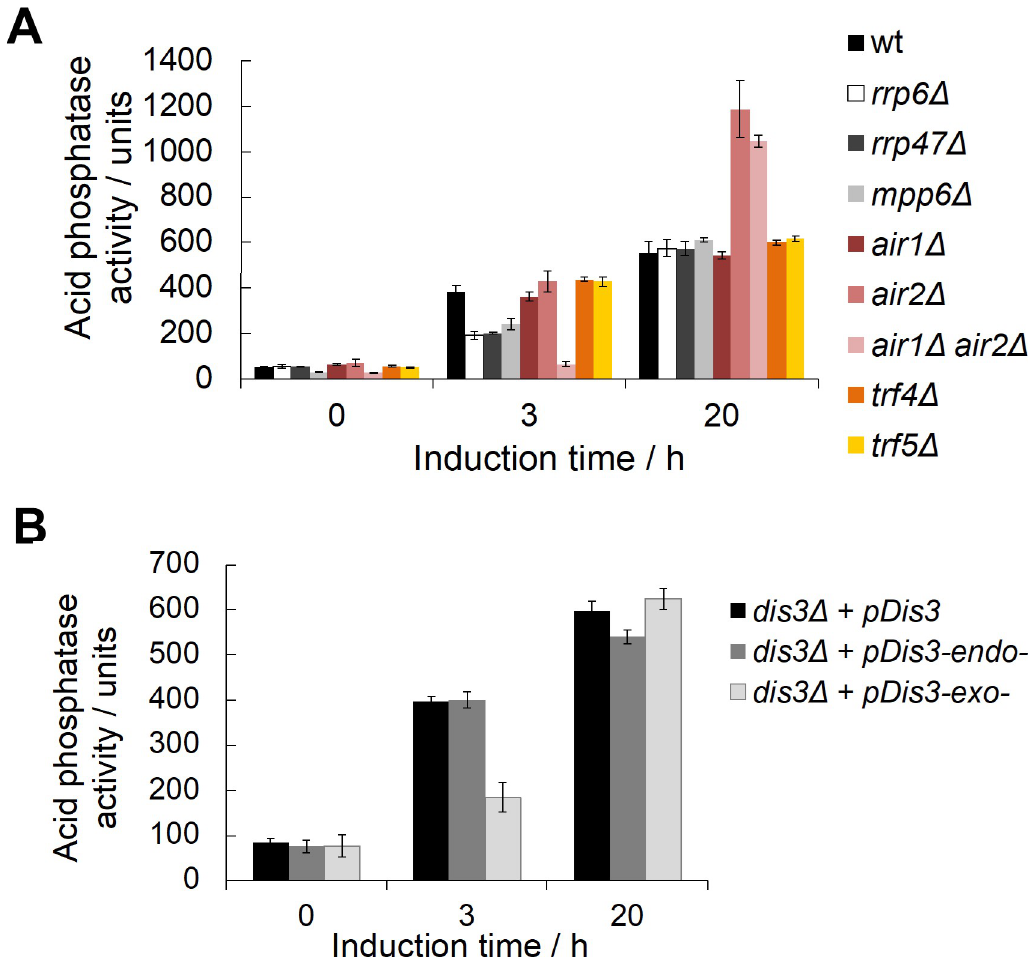
Fig 2. Expression of the PHO5 gene is negatively affected in RNA exosome mutant cells. (A) Acid phosphatase induction kinetics in wild-type BMA41 (wt) and corresponding deletion mutant cells for Rrp6 and RNA exosome cofactors upon induction through phosphate starvation. Reported values represent the means and standard deviations of three independent experiments (n = 3). (B) Same as (A), but for W303-derived strains with genomic copy of DIS3 gene deleted but bearing a centromeric plasmid that carries the wild-type copy of DIS3 gene ( dis3 Δ + pDis3 ) or its alleles with abolished endonuclease ( dis3 Δ + pDis3-endo - , D171N) or exonuclease ( dis3 Δ + pDis3-exo - , D551N) activity.